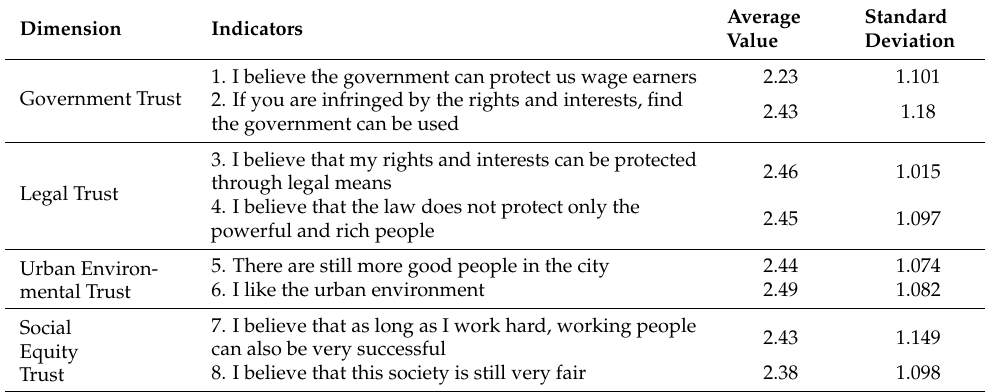
Table 2. Social trust evaluation